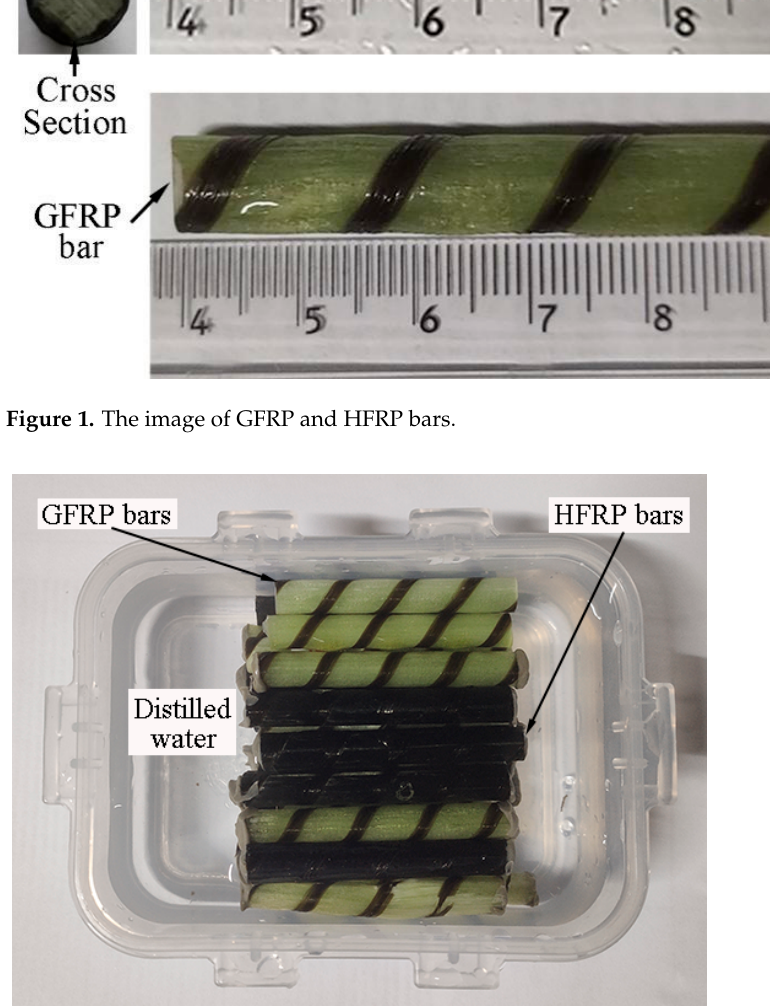
Figure 1. The image of GFRP and HFRP bars.